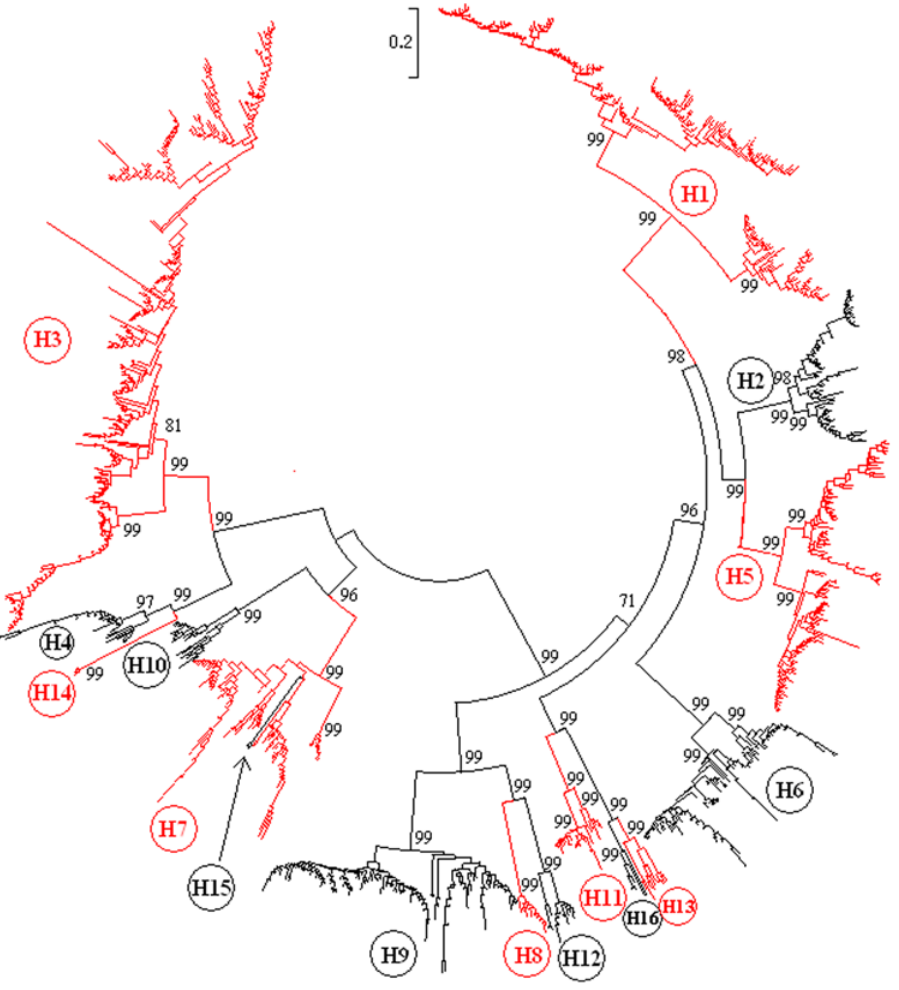
Figure 1. The panorama phylogenetic tree of type A influenza virus based on the viral HA sequences. The tree demonstrated that subtype H16 is close to subtype H13, and subtype H15 is similar to a lineage within subtype H7. The panorama diversity of each of the HA subtypes was detailed in Figure 3 , Figure 9. Bootstrap values were given at relevant nodes.